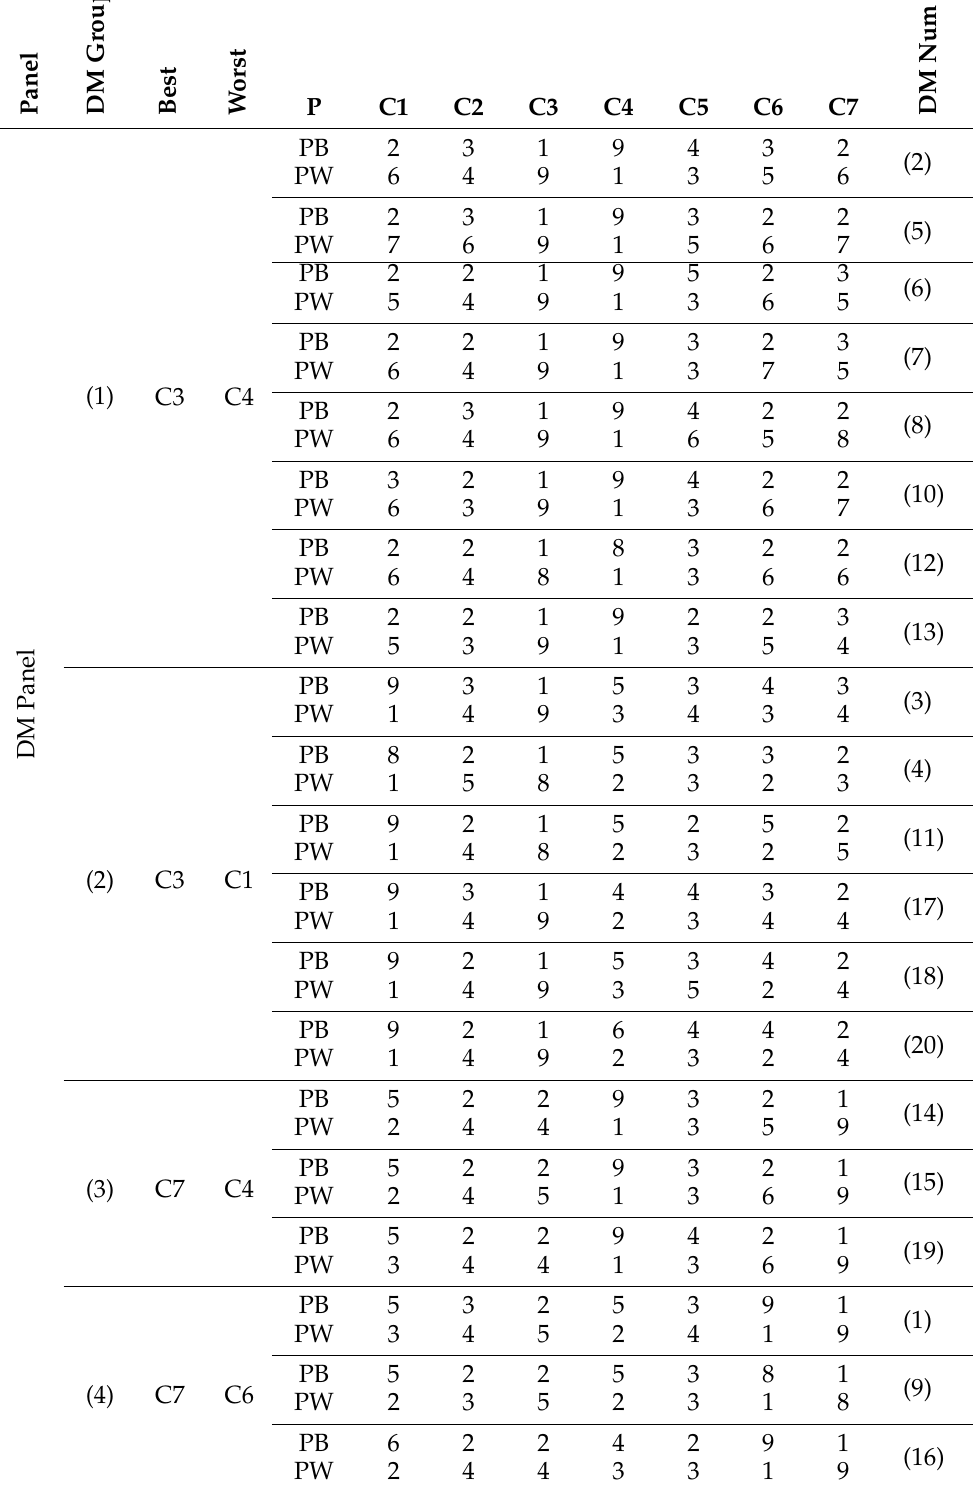
Table 2. Pairwise comparison vector for the best and worst